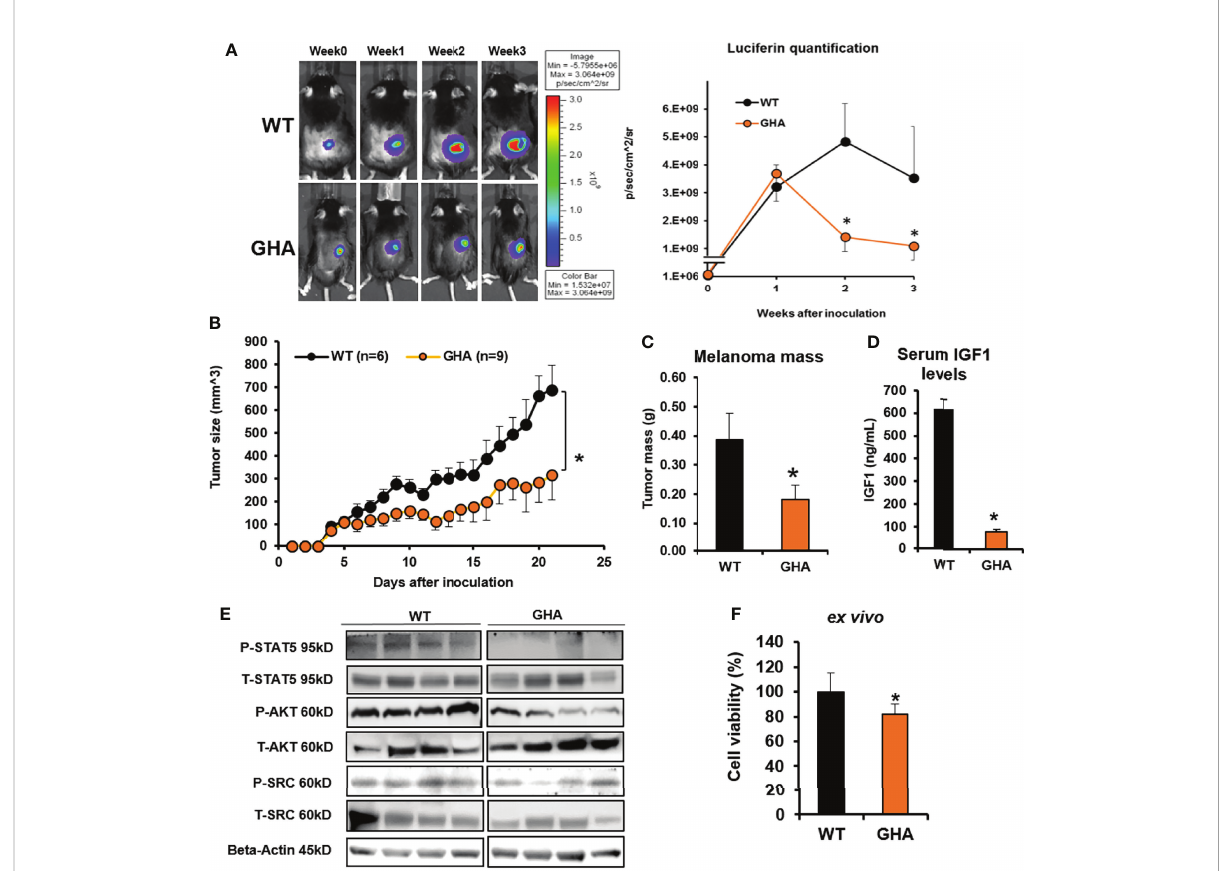
FIGURE 1 GHRA suppresses syngeneic mouse melanoma growth in vivo . (A) Mouse Fluc-B16-F10 cells grafted intradermally on the right fl ank of syngeneic C57BL6/J wild-type (WT) and GHA male mice (transgenic for bGH G119K GHR antagonist) (n=6). Tumor growth over 4-weeks was followed by luminescent imaging following luciferin injections. Luciferin signal was quanti fi ed and plotted on the right. The changes in tumor volume (Fluc-B16-F10 in WT and GHA mice) from digital caliper measurement (B) and tumor mass (C) corroborate the